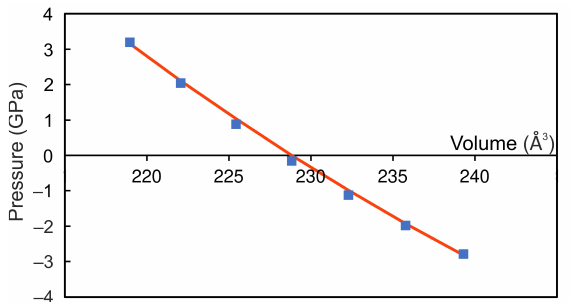
Figure 3. Pressure as a function of Fe 3 Se 4 volume. Blue dots indicate values for structures with finite strains ± 0.5, ± 1.0, ± 1.5%. The curve through this values fitted to the Birch–Murnaghan equation is marked by red.